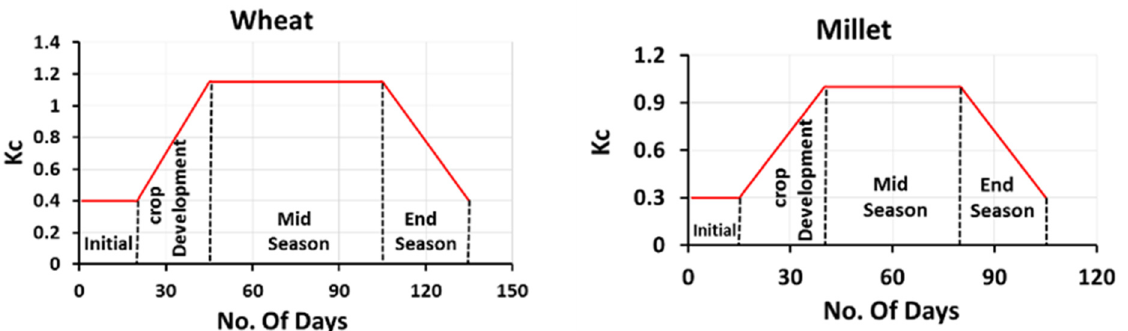
Figure 5. The crop coefficients of major summer (wheat) and winter (millet) crops.